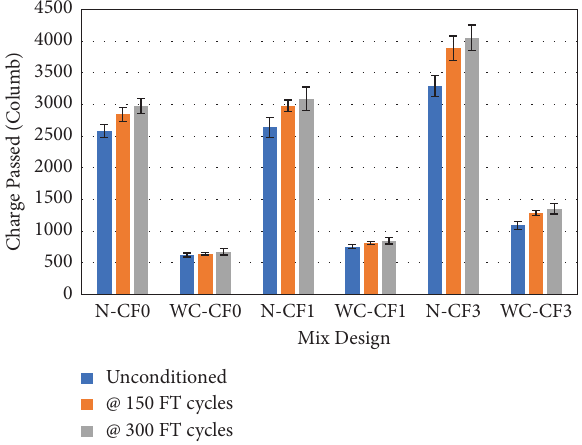
Figure 5: Results of a 28-day electrical resistance test. Figure 6: Results of 28days of the rapid chloride permeability test. Table 8: Relationship between chloride ion penetrability and charge passed in accordance with ASTM C 1202.